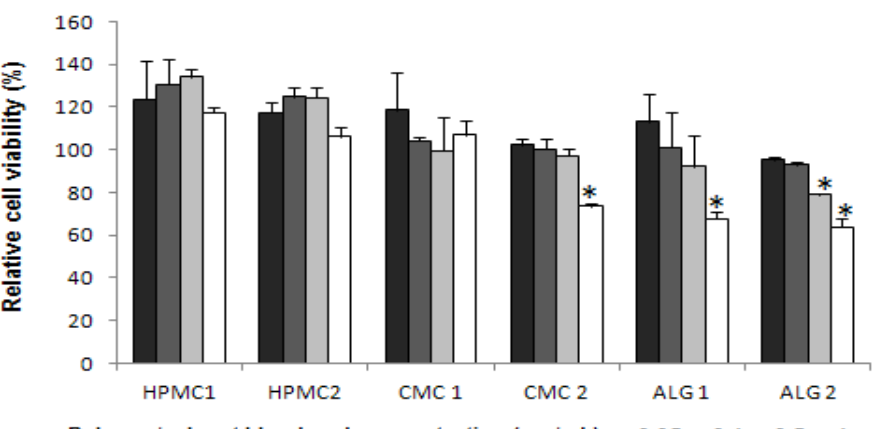
Figure 8. MAC-T cell viability in various concentrations of different formulated polymer/solvent sol phase blends after 72 h. Black, dark grey, light grey and white bars depict the various concentrations of each blend: 0.05 mg/mL, 0.1 mg/mL, 0.5 mg/mL, 1 mg/mL. Cell viability was detected by MTT assay and eexpressed as a percentage of cell viability in untreated controls (mean ± SD, n = 3). The standard deviation is shown by the error bars. * denotes significance from negative control. (Legend: HPMC1 = HPMC 10%, G 49.5%, E 22.5%, W 18%; HPMC2 = HPMC 10%, G 9%, PG 72%, W 9%; CMC